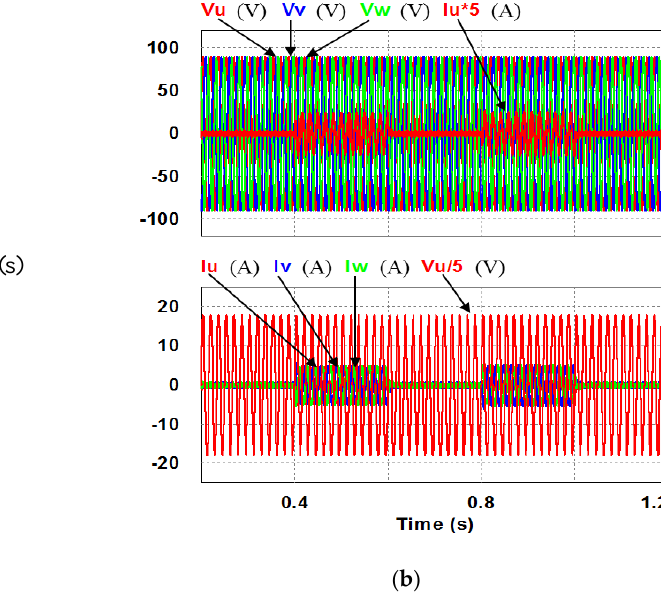
( b ) Figure 15. Detailed views of Figure 14 b : ( a ) from 0.3 to 0.5 s; ( b ) from 0.5 to 0.7 s.